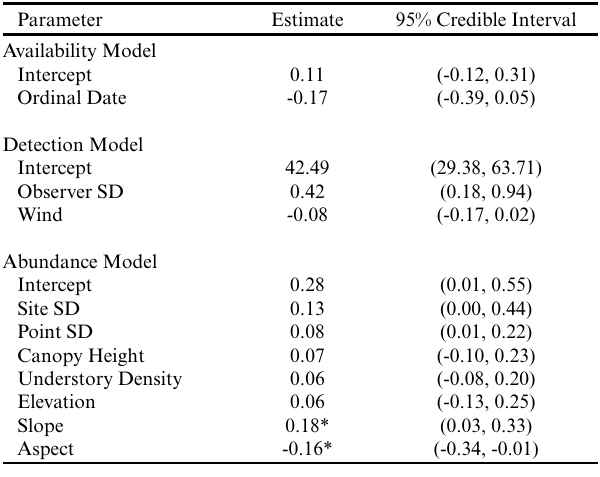
Table 1 . Output from the N-mixture model for Worm-eating Warblers ( Helmitheros vermivorum ). Estimates of covariates with effects we considered significant (the 95% credible interval did not overlap zero) are marked with an asterisk. SD = standard deviation.